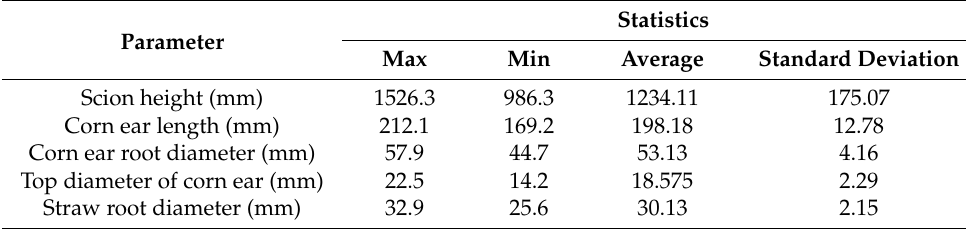
Table 1. Growth parameters of corn